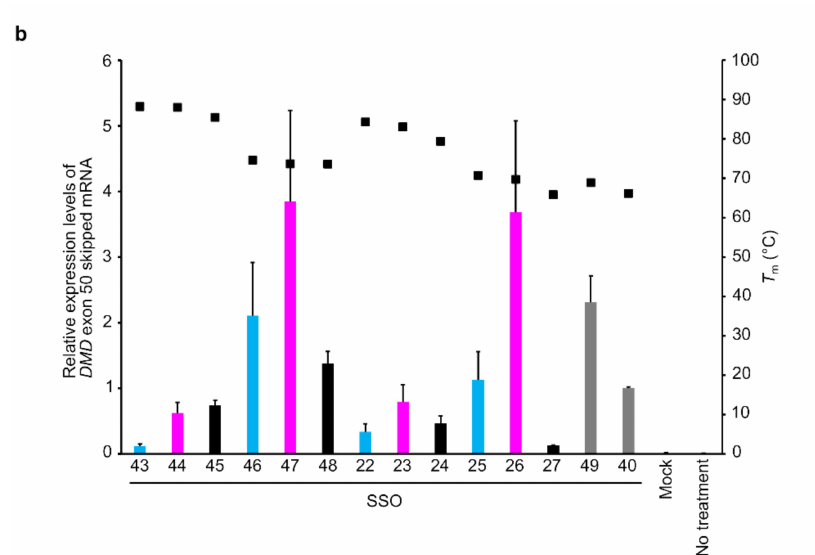
Figure 5. Design and evaluation of 21-mer LNA/AmNA/GuNA/2 (cid:48) -OMe RNA-modified SSOs targeting DMD exon 50 and having different lengths and modification content using stably transfected cells. ( a ) Schematic representation of 21-mer SSOs used for the assay. ( b ) RT-qPCR analysis results. Stable-e50 cells were transfected with the indicated SSOs (30 nM) for 24 h. On the X -axis of the graph, transfected SSOs are shown with SSO numbers mentioned in ( a ). The expression of exon 50-skipped mRNA was measured by RT-qPCR (bar). The expression was normalized to the RPLP2 mRNA signal, relative to the value of 18/18_2 (cid:48) -OMe_e50+16 (SSO 40) set to 1. Values represent the mean ± standard deviation of three independent experiments performed in duplicate. T m value of SSOs was measured from 5 to 94.5 ◦ C (black box). Mock: treated with Lipofectamine only; no treatment: no transfection. Values represent the mean ± standard deviation of three independent